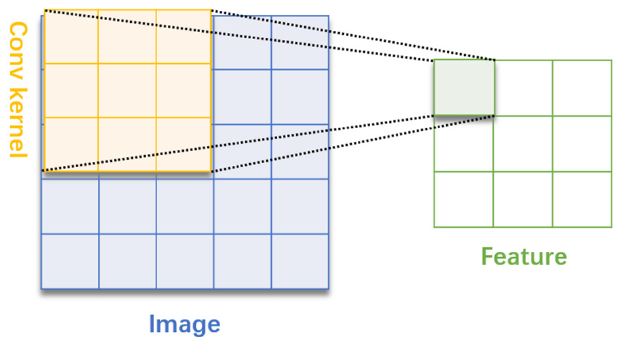
Figure 1. Schematic diagram of convolution process.